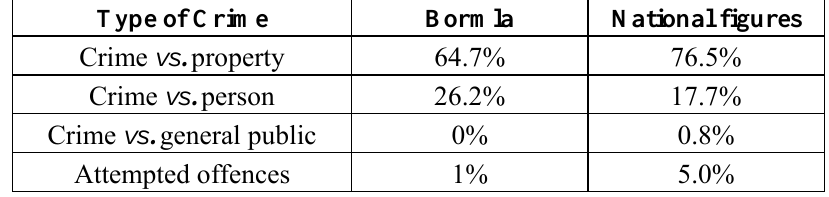
Table 3. Type of crime committed in Bormla in 2009 compared to national figures.